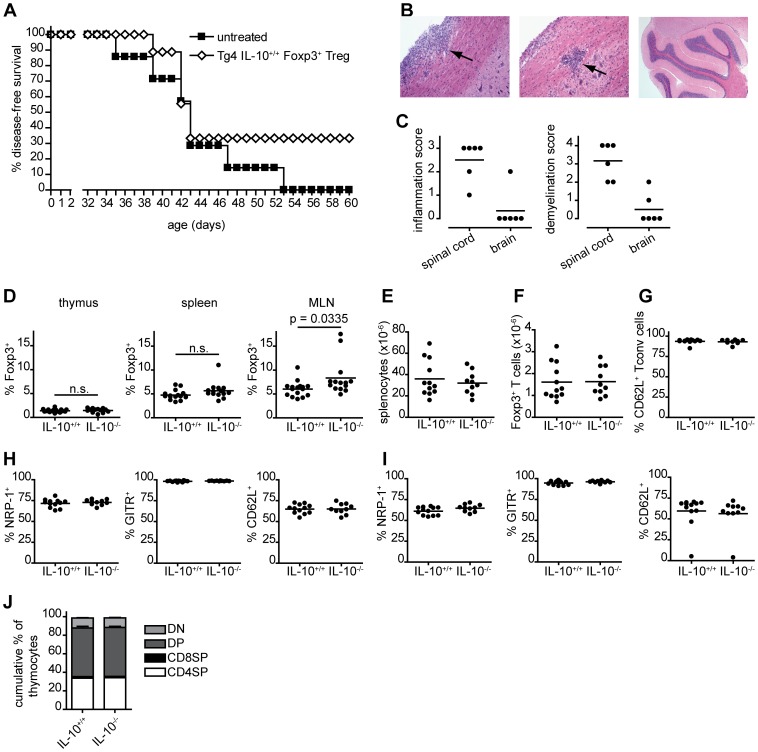
Tg4 IL-10−/− mice exhibit spontaneous EAE but no deficiency in Foxp3+ Treg cell numbers or phenotype.A. Tg4 IL-10−/− mice, untreated, n = 7, or receiving 1.5×106 Tg4 IL-10+/+ splenic Treg cells i.p. at age 4–5 weeks, n = 9, were monitored daily for the spontaneous development of CNS autoimmune disease. Logrank test, P = 0.25 B. Representative haematoxylin/eosin stained sections of spinal cord (left and middle) and brain (right) from Tg4 IL-10−/− with established CNS autoimmune disease (n = 6). Arrows indicate lymphocytic infiltrate. Magnifications: left; ×200, middle; ×100, right; ×25. C. Inflammation and demyelination scores of spinal cord and brain sections of Tg4 IL-10−/− with established disease. Horizontal lines indicate means. n = 6 each. D-J. Tg4 IL-10+/+ and Tg4 IL-10−/− mice approximately 5 weeks of age were examined for a number of characteristics; D. Frequency of Foxp3+ cells among CD4+CD8− (CD4SP) thymocytes or CD4+ T cells in the spleen and mesenteric lymph nodes (MLN). Thymus; Tg4 IL-10+/+ n = 16, Tg4 IL-10−/− n = 13. Spleen and MLN; Tg4 IL-10+/+ n = 16, Tg4 IL-10−/− n = 14. E. Total number of splenocytes. F. Number of CD4+Foxp3+ cells in the spleen. G. Percentage CD62L expression on splenic CD4+ Foxp3− cells. H. Percentage Neuropilin-1 (NRP-1), GITR and CD62L expression on splenic CD4+Foxp3+ cells. I. Percentage NRP-1, GITR and CD62L expression on CD4+Foxp3+ cells in the MLN. J. Cumulative frequency of CD4 and CD8 single positive (SP), double positive (DP) or double negative (DN) thymocytes. E–J. Tg4 IL-10+/+ n = 12, Tg4 IL-10−/− n = 10. D–I. statistical analysis by unpaired, 2-tailed, t-test. Panels E-I; no significant differences.